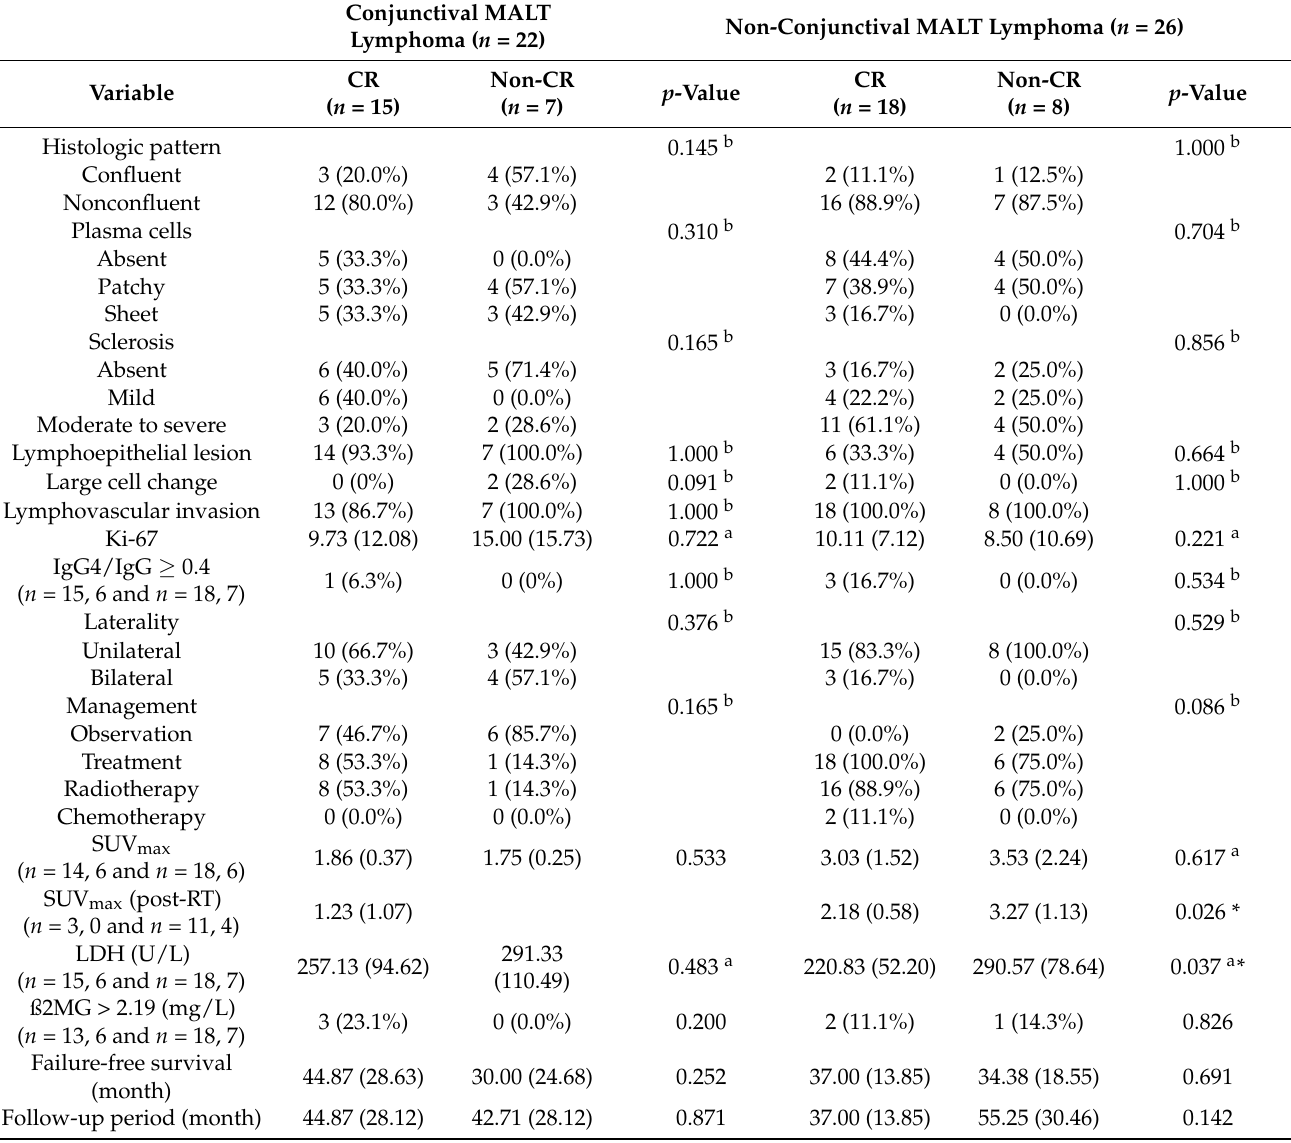
Table 4. Comparison of clinicopathologic characteristics between conjunctival and non-conjunctival MALT